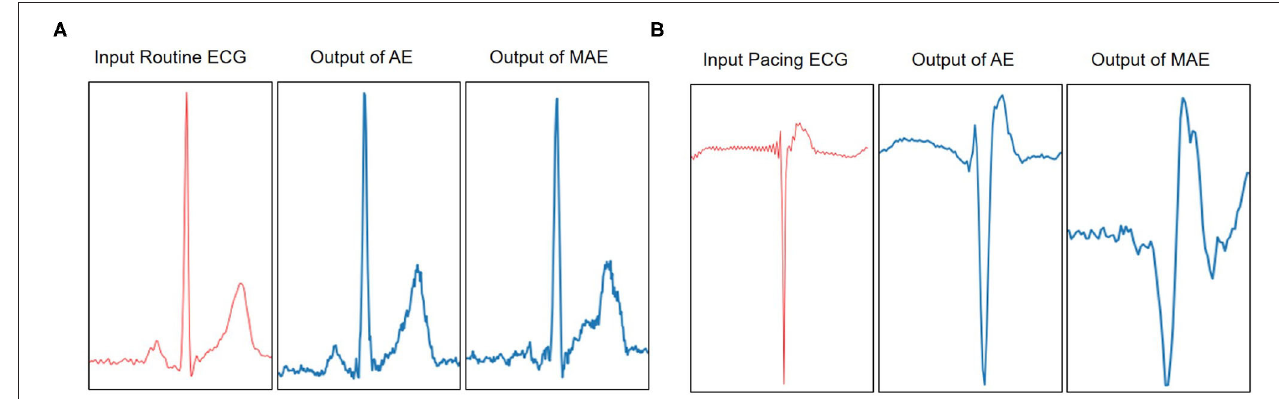
FIGURE 5 | Visualization of the reconstruction results of AE and MAE on Pacing ECG. (A) The example model is trained on a type of pacing ECG. The input data is a routine ECG. Due to the periodicity of the ECG, the reconstruction data from the traditional AE model is also close to the input data. It is a failure case of ECG reconstruction in terms of error. But the MAE retrieves the training types memory items for reconstruction data and obtains the results significantly different from the input data types. The significant error between the reconstruction data and the input data means that the input data does not belong to pacing ECG. (B) The example model is trained on a type of routine ECG. The input data is a pacing ECG. The traditional AE model gets a failure case on the input data. But the MAE model obtains a higher significant error between reconstructions data and the input data. Therefore, it shows that the input data is a different type from the type of model.